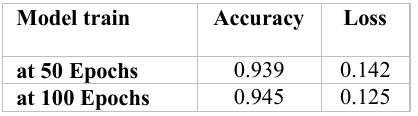
Table 2. The results of the evaluation